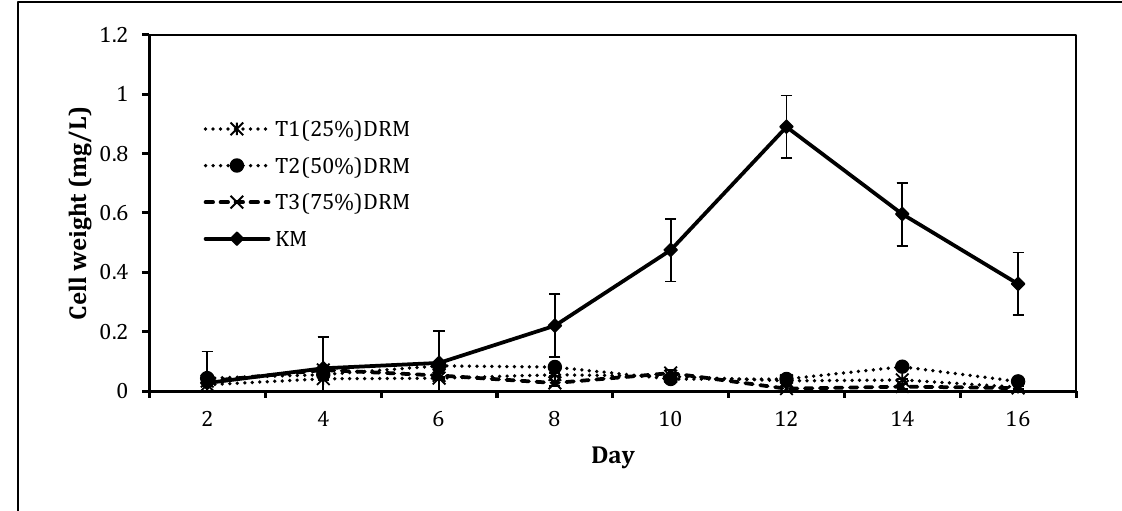
Figure 2: Mean values of cell weight (mg/L) of S. platensis grown in supernatant of three different digested rotten mangoes, and Kosaric medium. Vertical bars represent standard